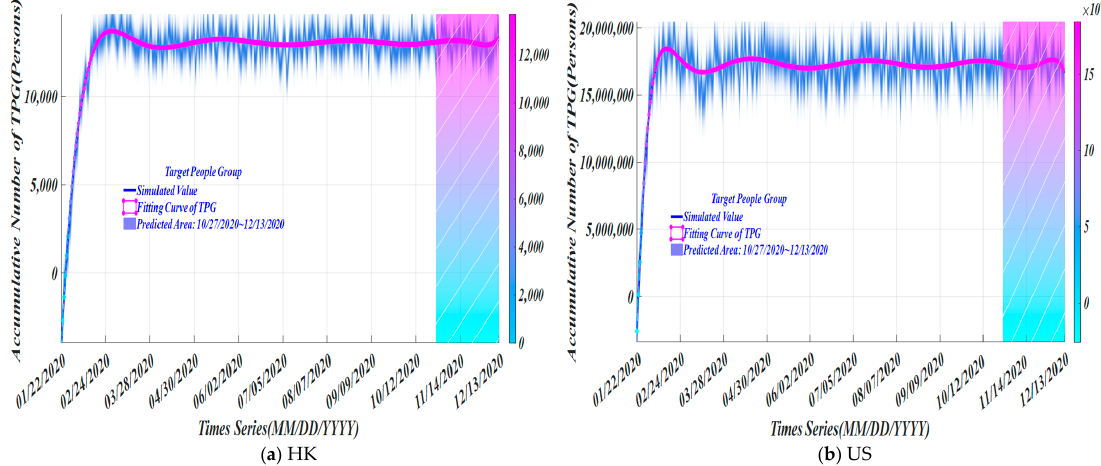
Figure 4. The trend of simulated number of TPG.